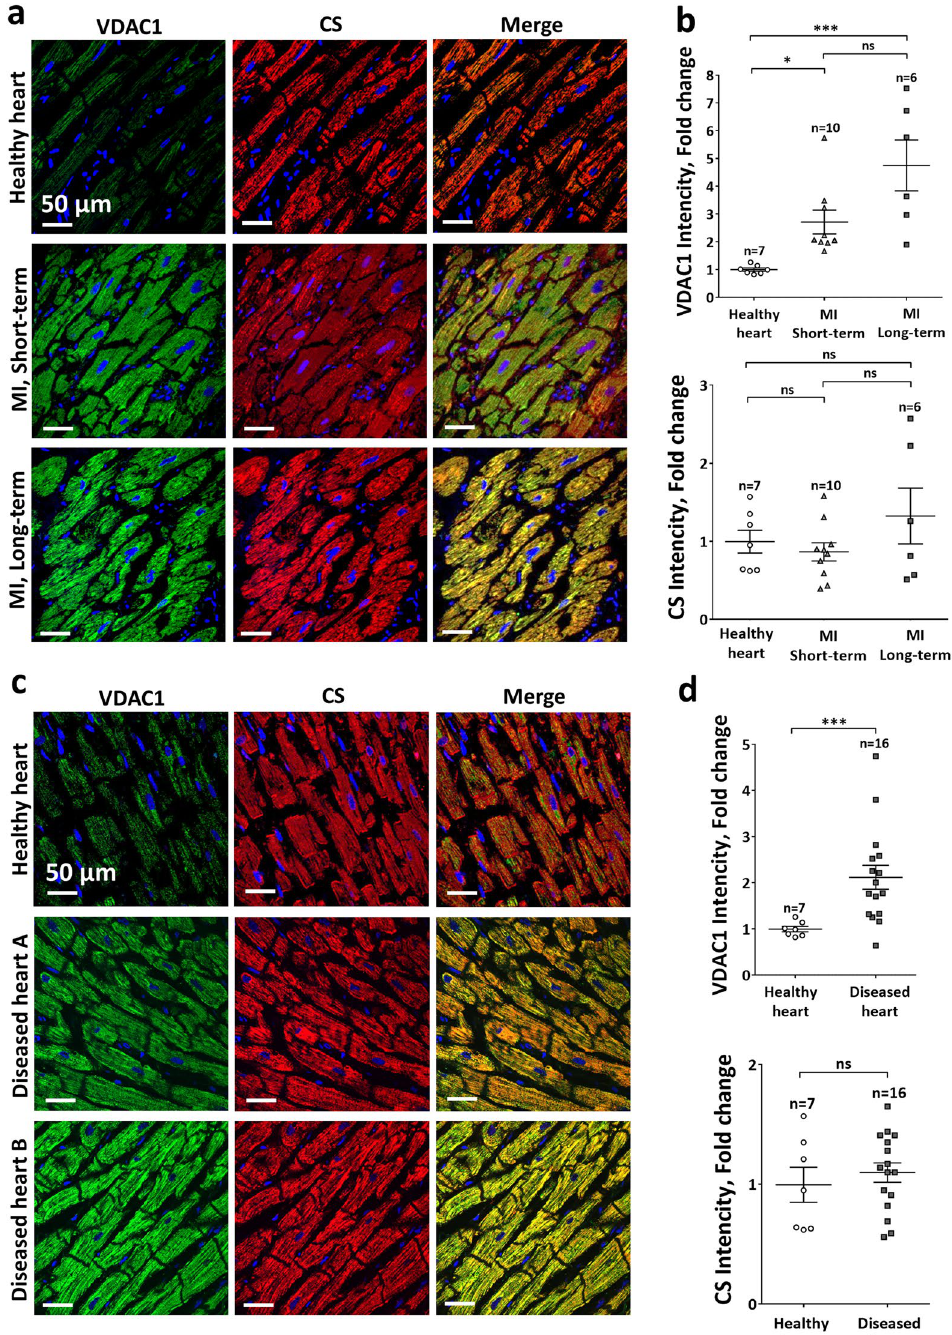
Figure 2. The overexpression of VDAC1 in human cardiac pathologies does not signify changes in mitochondrial mass. Co-immunofluorescent staining of the human cardiac tissue arrays with a VDAC1 specific antibody (ab186321, Table S4) as well as an antibody for citrate synthase (CS) to quantify mitochondrial mass/ amount. ( a , b ) analysis of the same MI samples as in Fig. 1a,b. ( a ) Representative photomicrographs for each condition demonstrating staining for VDAC1 (green), CS (red) and both (Merged) . Scale bars, 50 µm. ( b ) Summarizing scatter plot of quantitative image processing analysis. ( c , d ) analysis of the diseased LV samples as in Fig. 1c,d. ( c ) Representative photomicrographs for each condition demonstrating staining for VDAC1 (green), CS (red) and both (Merged) . Scale bars, 50 µm. ( d ) Summarizing scatter plot of quantitative image processing